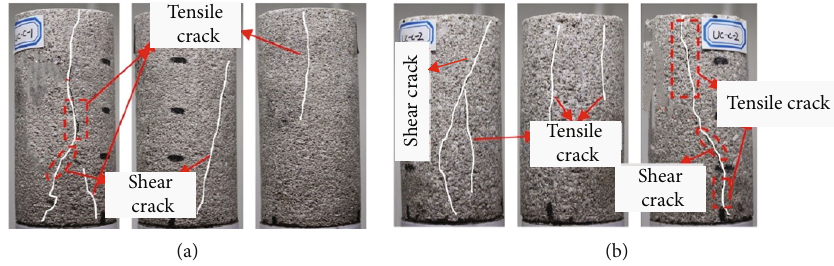
Figure 2: Failure modes of the sandstone specimens: (a) UC-C-1; (b)